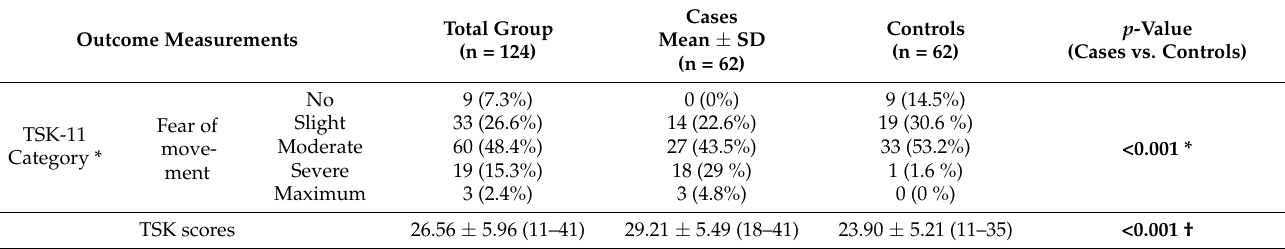
Table 2. Comparisons of TSK-11 scores and categories between patients with Parkinson’s disease (PD) patients and patients without PD (matched-paired